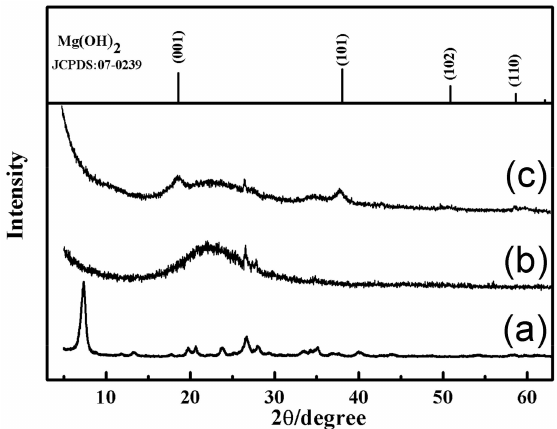
Figure 2. Representative XRD patterns of raw sepiolite ( a ), acid-activated sepiolite ( b ), and sepiolite modified by sequential acid–base treatment ( c ).